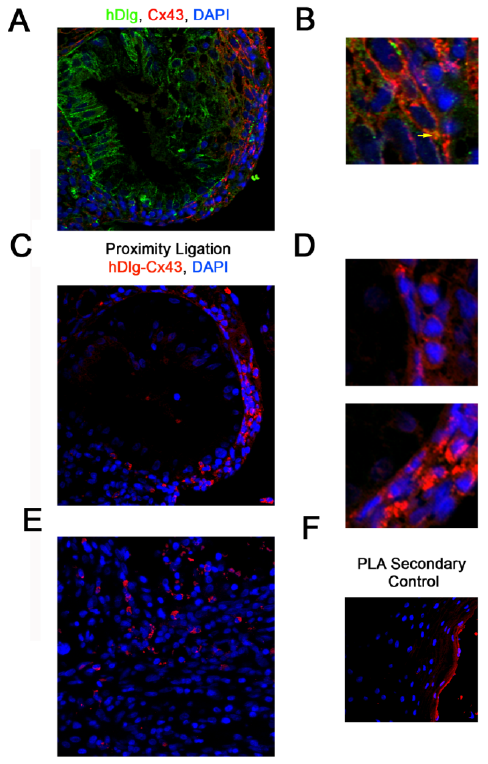
Figure 1. Cx43 and hDlg interact directly in cervical tumour cells in vivo . ( A ) Representative immunofluorescence image showing a section of a high grade cervical lesion; ( B ) A region of Cx43 and hDlg colocalisation in ( A ) enlarged 5×. Immunofluorescence shows hDlg (green), Cx43 (red) and DAPI (blue). The yellow arrow indicates one area of Cx43/hDlg colocalisation; ( C ) Immunofluorescence proximity ligation for hDlg and Cx43, where red staining indicates colocalisation of the proteins within 40 nm of each other; ( D ) Regions of Cx43 and hDlg colocalisation detected by PLA in C enlarged 5×; ( E ) Immunofluorescence proximity ligation for hDlg and Cx43 in a region of a cervical tumour; ( F ) Immunofluorescence proximity ligation secondary control on the outer region of the cervical lesion a part of which is shown in ( C ).